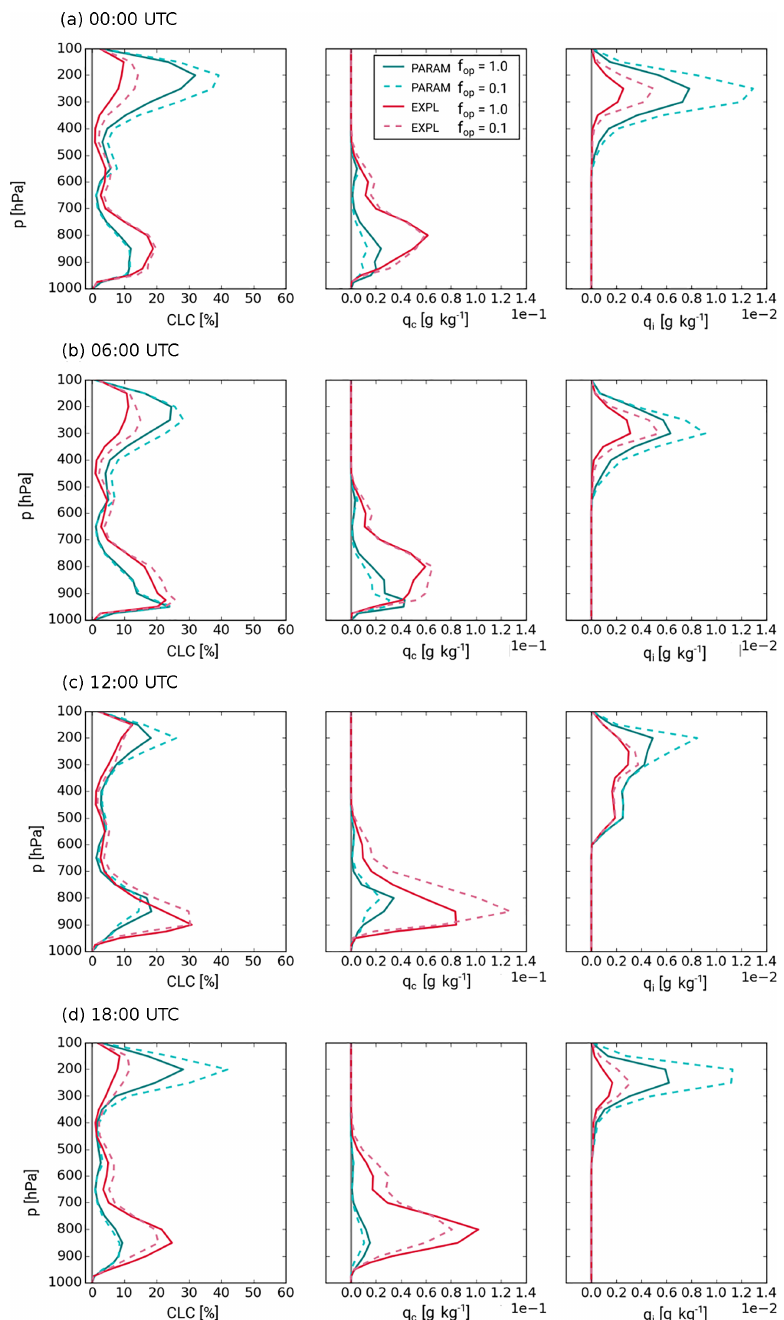
Figure 6. July 2006 mean profiles of CLC, q c and q i averaged over the DACCIWA box for experiments PARAM (green) and EXPL (red) and varying f op according to the legend at the top: (a) 00:00UTC, (b) 06:00UTC, (c) 12:00UTC and (d)